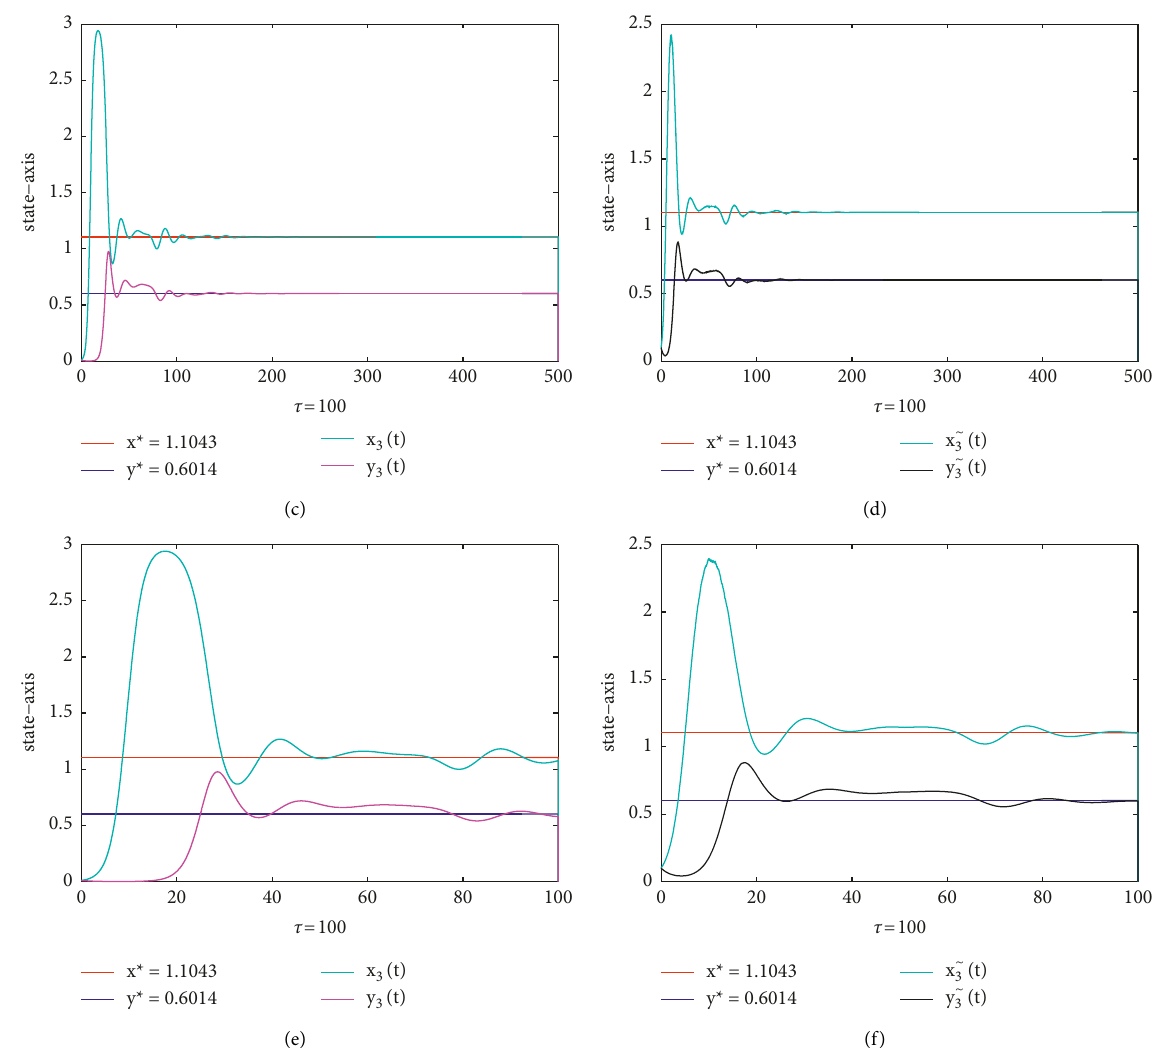
Figure 3: The influence of τ on the stability of E ∗ ( x ∗ , y ∗ ) of (2) and (21) with τ represent the intensities of prey species, and y i ( t ) and y ∼ i ( t ) , i � 1 , 2 , 3 represent the intensities of predator species of (2) and (21), respectively. (a) The time series graph of (2) with different τ i ( i � 1 , 2 , 3 ) . (b) The time series graph of (21) with different τ i ( i � 1 , 2 , 3 ) . (c) The time series graph of (2) with ϕ local part of (c) as t ∈ [ 0 , 100 ] . (f) The local part of (d) as t ∈ [ 0 , 100 ]